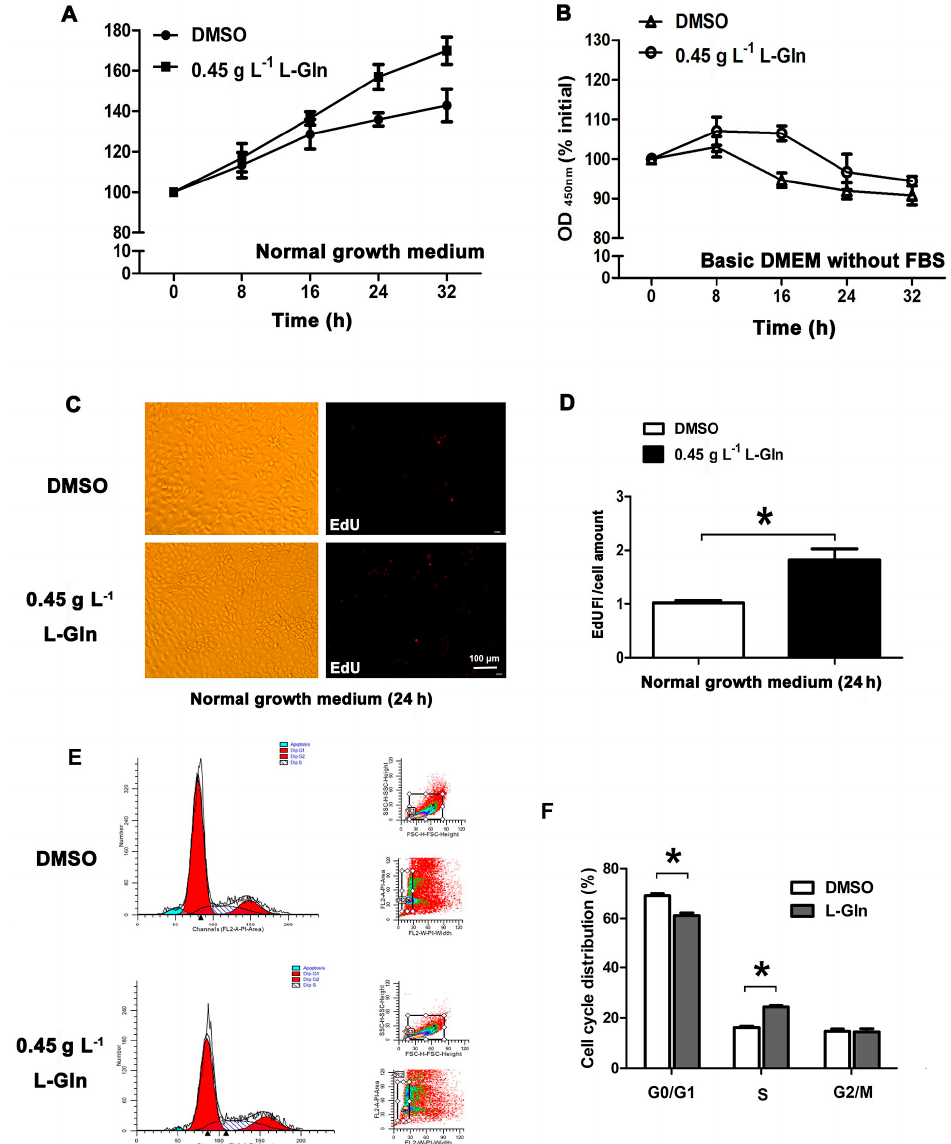
Figure 2. L -glutamine promotes cell proliferation within specific milieu. ( A ) In the normal growth medium, cells were treated with DMSO or 0.45 g L − 1 L -glutamine for 0 to 32 h, followed by a cell viability assay using CCK-8; ( B ) In basic DMEM, relative cell viability was measured using CCK-8 after treating cells with DMSO or 0.45 g L − 1 L -glutamine for 0 to 32 h; ( C , D ) After the treatment described in A, cell proliferation rate was determined by EdU staining, and the results are shown as relative EdU fluorescent light/cell values; ( E , F ) After the treatment described in A, cell cycle distribution was determined by flow cytometry; the statistical results are shown here. Data given as means ± SDs for the three independent experiments (* means under T test, p < 0.05, ** means under T test, p < 0.01).